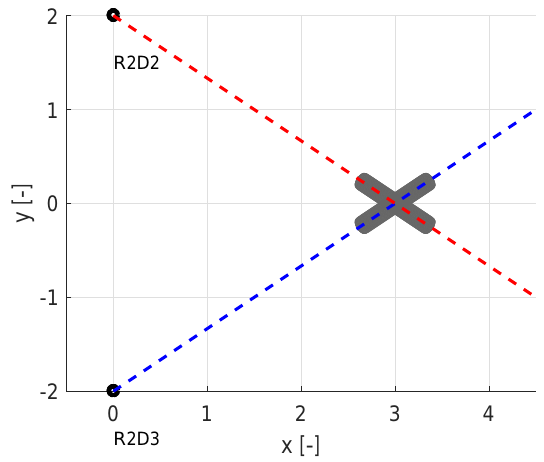
Figure 6. Sketch of the probe volumes of both lidars (not to scale).